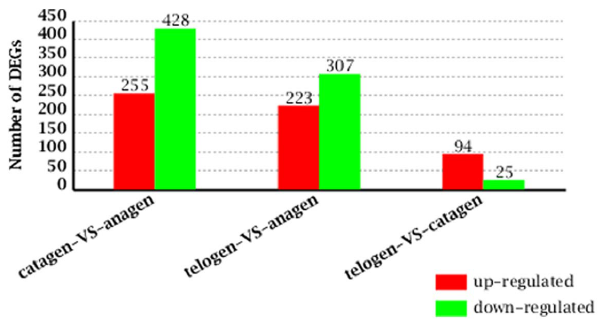
Figure 3. The numbers of DEGs between different develop- mental stages. Between the anagen and catagen libraries, there were 255 upregulated genes and 428 downregulated genes; Between the anagen and telogen libraries, there were 223 upregulated genes and 307 downregulated genes, while there were 94 upregulated genes and 25 downregulated genes between the catagen and telogen